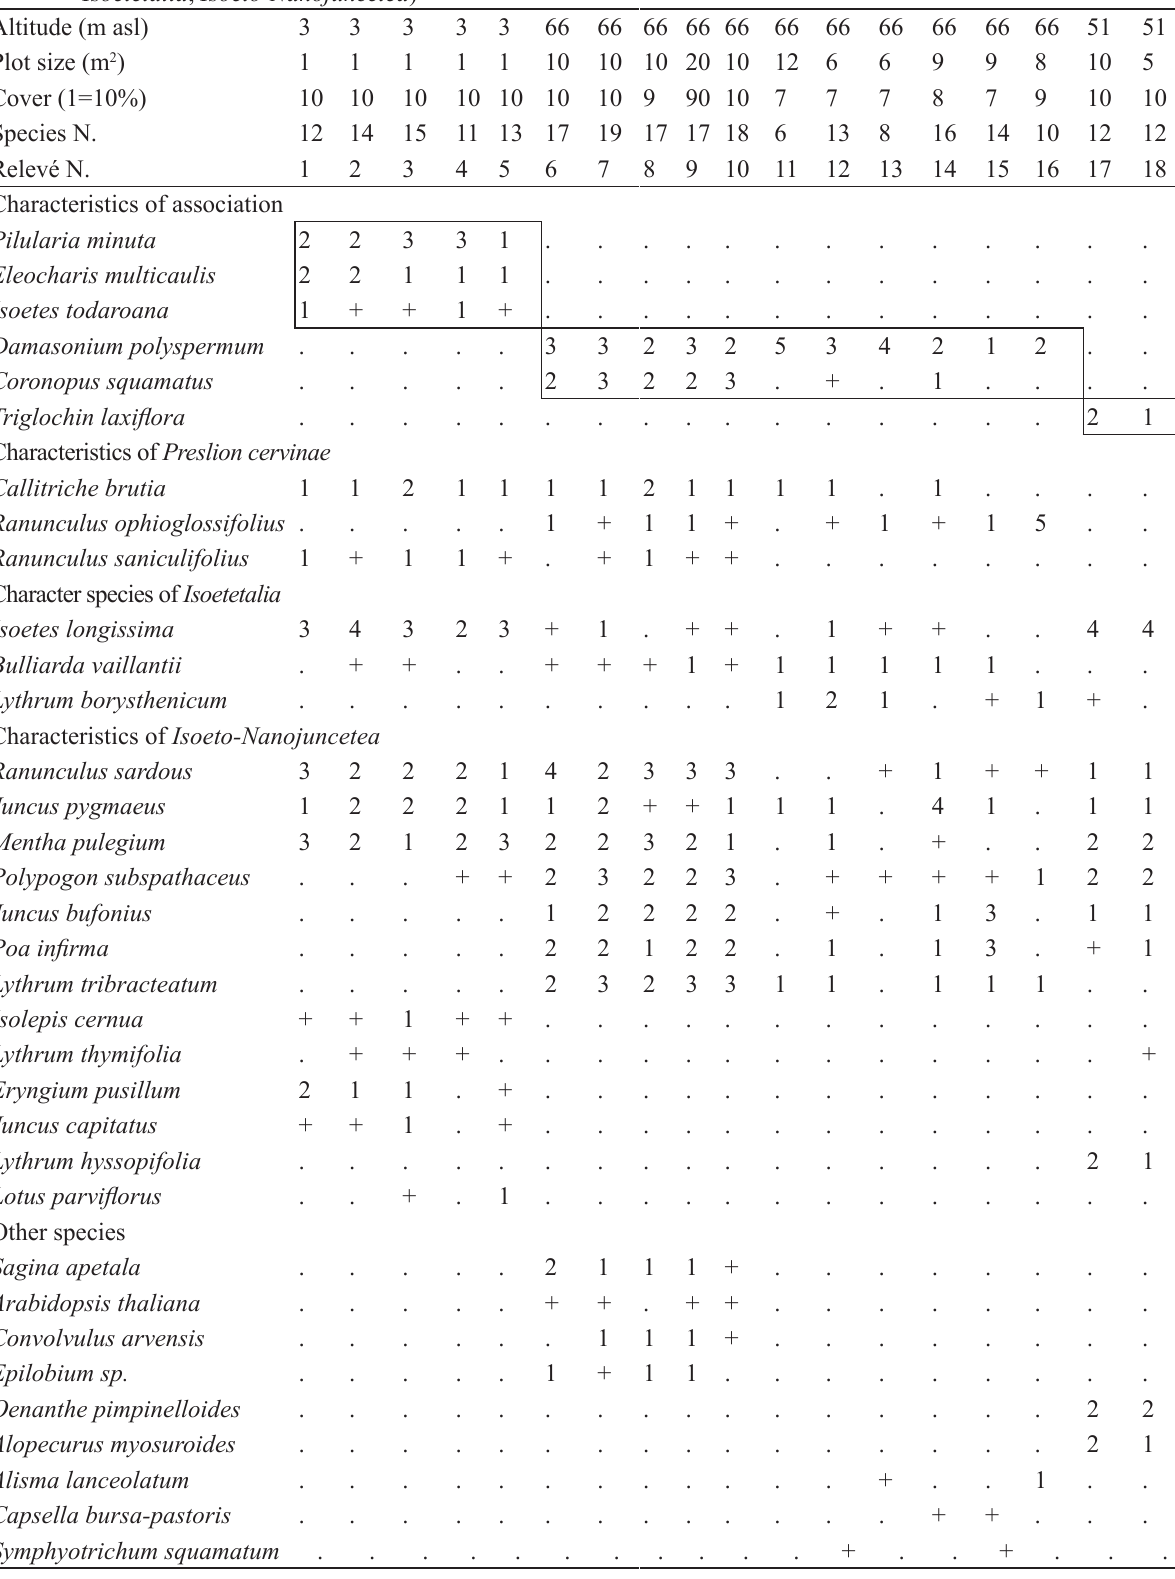
Table 4. Pilulario minutae-Isoetetum longissimae ass. nova (rel. 1-5), Coronopo squamati-Damasonietum polyspermi ass. nova (rel. 6-16), Triglochido laxiflorae-Isoetetum longissimae ass. nova (rel. 17, 18) ( Preslion cervinae , Isoetetalia , Isoeto-Nanojuncetea ) Altitude (m asl) Plot size (m 2 ) Cover (1=10%) Species N. Characteristics of association